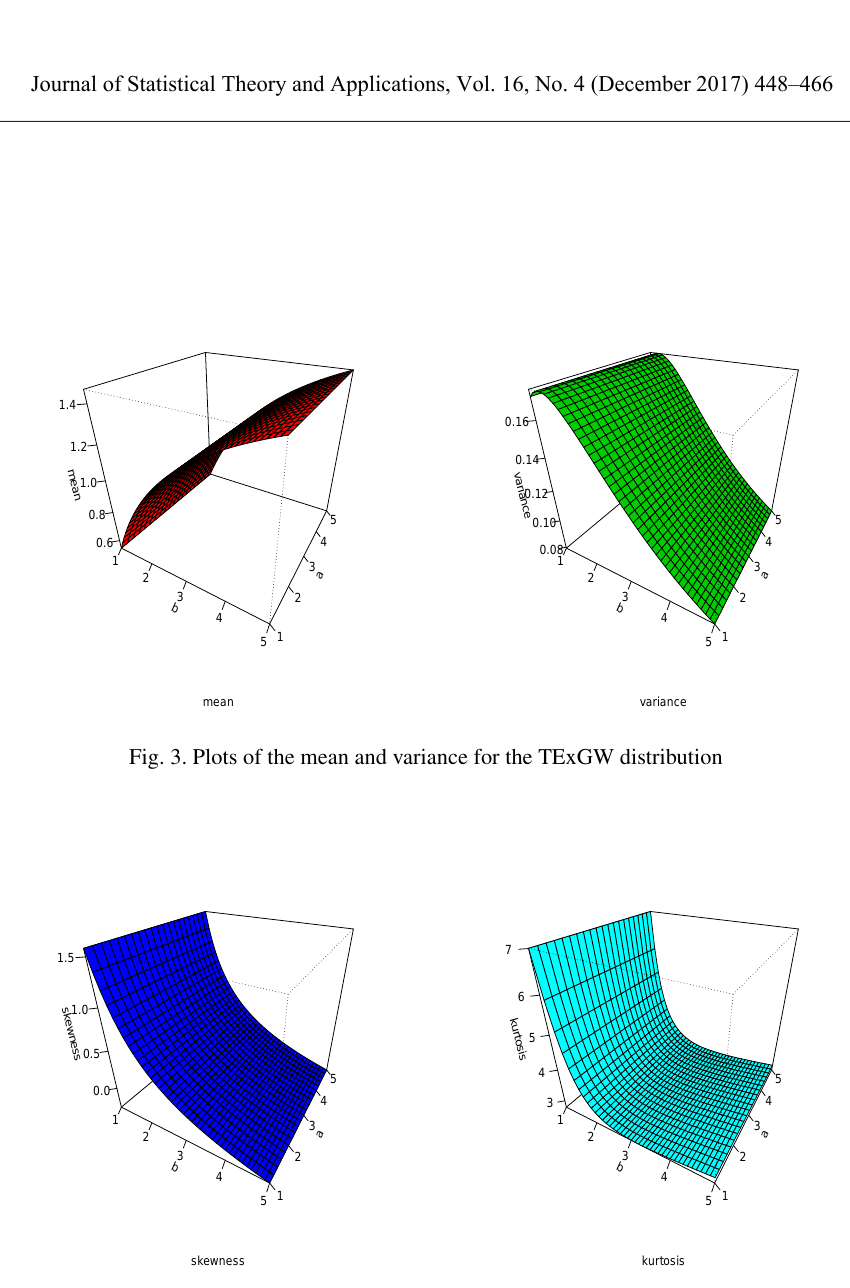
Fig. 4. Plots of the skewness and kurtosis for the TExGW